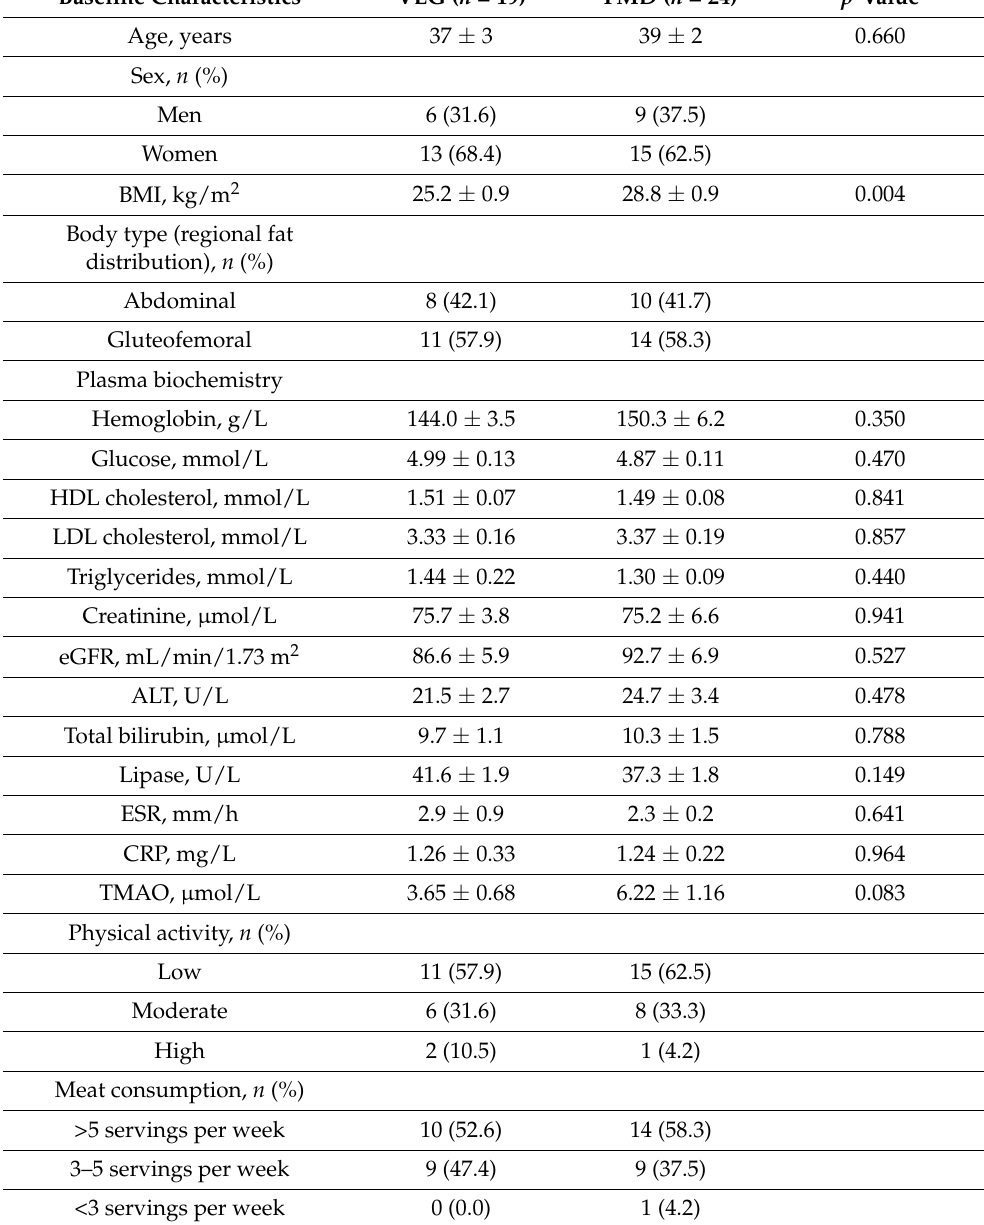
Table 1. Baseline data characterizing bio-anthropometric and biochemical parameters of the study